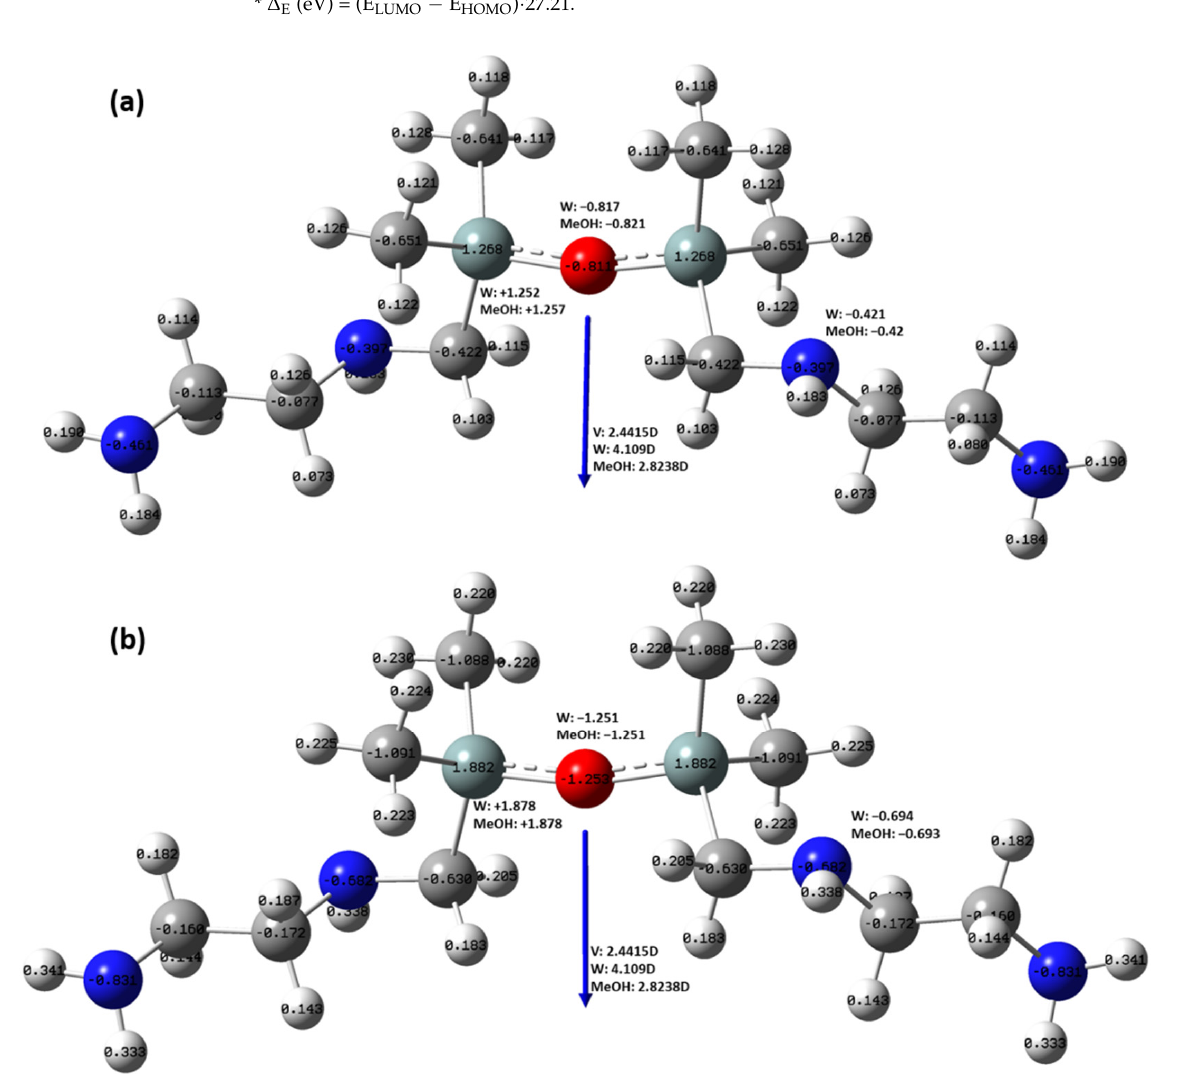
Figure 4. Partial charges for AEAMDS: ( a ) Mulliken, ( b ) NPA from NBO; implicit solvents: W—water, MeOH—methanol, V—vacuum.